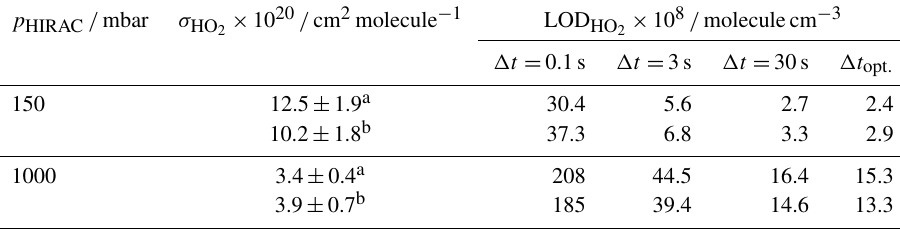
a Determined using the line strengths of the HO 2 transitions contributing to the absorption at 1506.43nm (Thiebaud et al., 2007) and the pressure-broadening coefficients (Ibrahim et al., 2007) (Sect. 3.2). b Determined using the kinetics of the HO 2 second-order decays (Sect. 3.3).